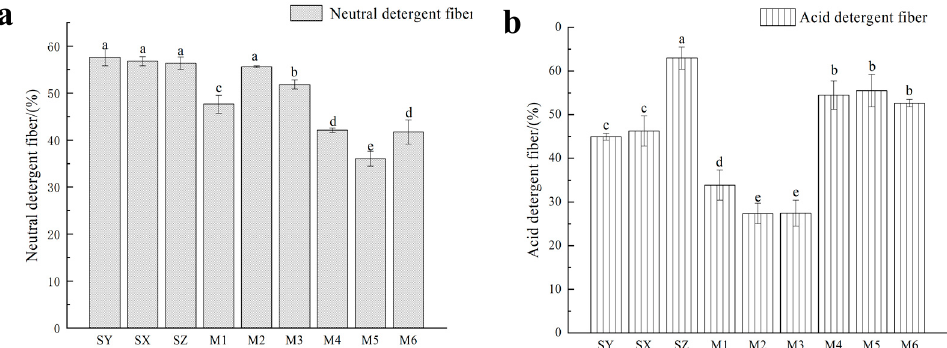
Figure 3. Contents of NDF ( a ) and ADF ( b ) after mixed silage of rapeseed with alfalfa or Myriophyllum spicatum in different proportions. Note: Different lowercase letters indicate significant difference between different treatment groups ( p < 0.05)